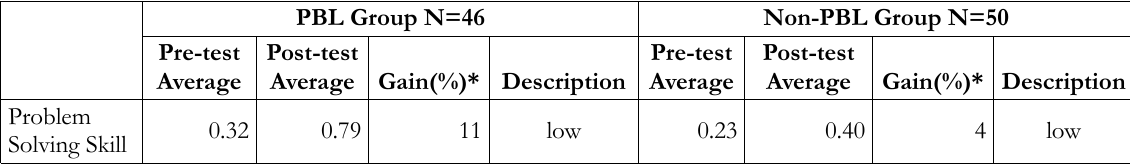
Table 9. Percent Gain of Problem Solving Skills of PBL and Non-PBL